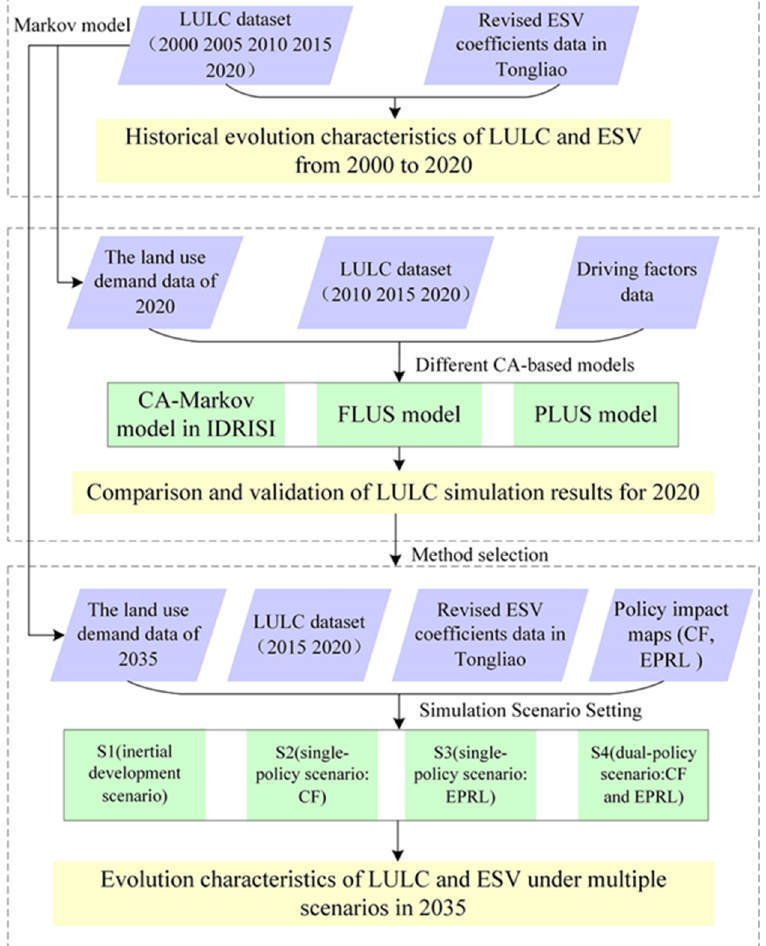
Figure 1. The flowchart for this methodology.